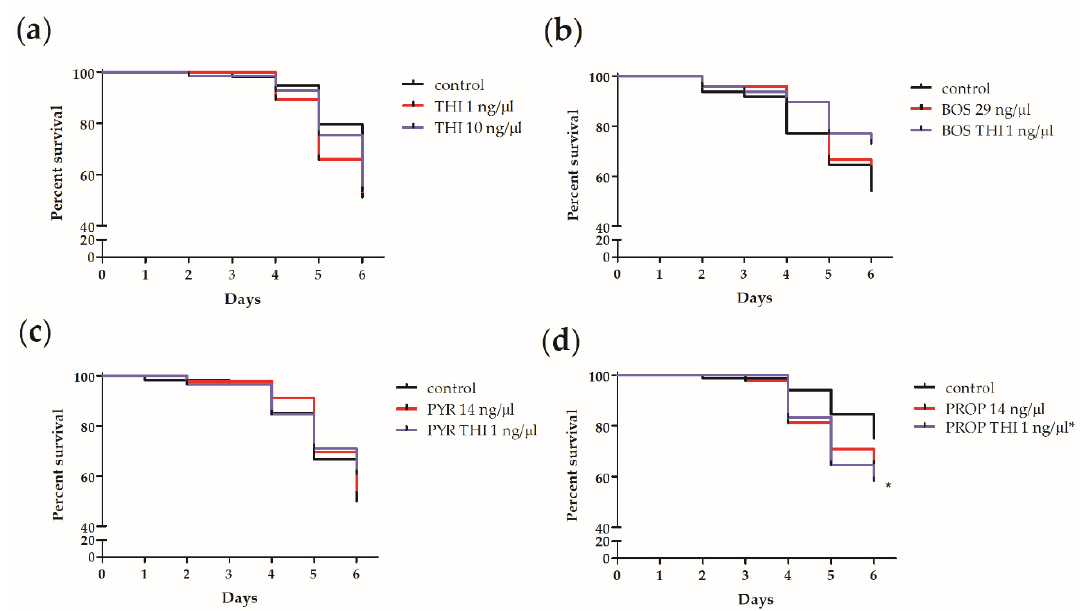
Figure 3. E ff ects of chronic pesticide exposure on survival of larvae infected with 50 colony forming units (CFU) of Melissococcus plutonius . ( a ) Percentage survival of larvae fed control diet or diet with thiamethoxam (THI; 1 or 10 ng / µ L); ( b ) Percentage survival of larvae fed control diet, diet with boscalid (BOS; 29 ng / µ L), or diet with BOS and THI (1 ng / µ L); ( c ) Percentage survival of larvae fed control diet, diet with pyrimethanil (PYR; 14 ng / µ L), or diet with PYR and THI (1 ng / µ L); ( d ) Percentage survival of larvae fed control diet, diet with propiconazole (PROP; 14 ng / µ L), or diet with PROP and THI (1 ng / µ L). From day 0 to day 5, larvae were fed control or pesticide-contaminated diet and mortality was recorded daily for 6 days after grafting on day 0. Lines indicate percent daily survival for 46–84 larvae administered 50 CFU on day 0 of in vitro rearing. * indicates significant ( p < 0.05) di ff erence relative to control by Cox proportional hazards regression. Thiamethoxam and propiconazole exposure increased susceptibility of honeybee worker larvae to mortality from European foulbrood in vitro , after infection with 50 CFU of Melissococcus plutonius